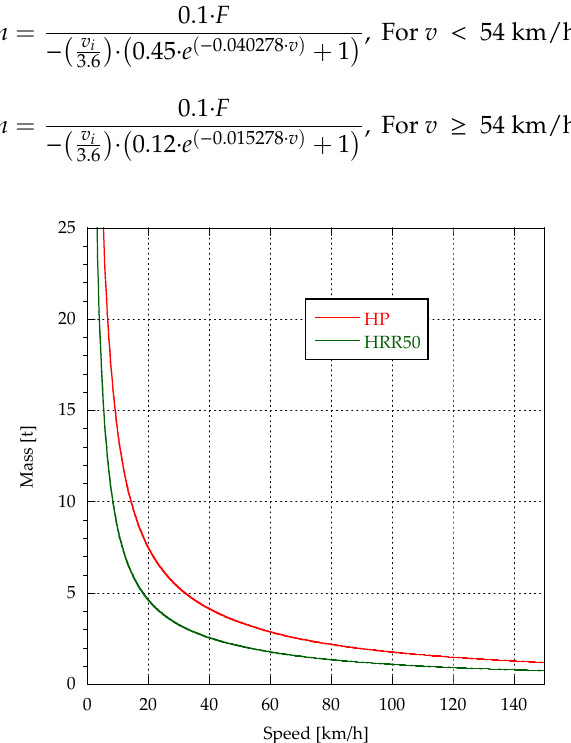
Figure 12. Simulated behavior of reinforced barriers.